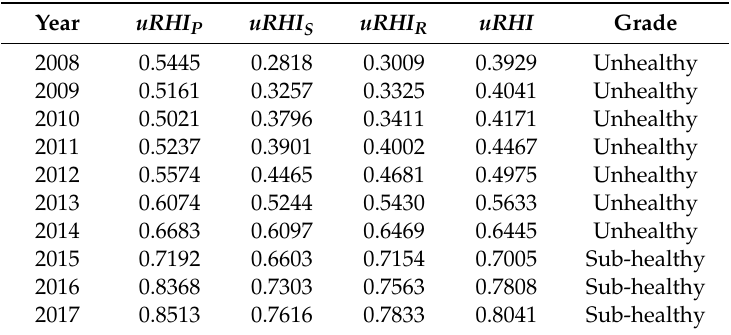
Table 5. uRHI and health grade of Jialu